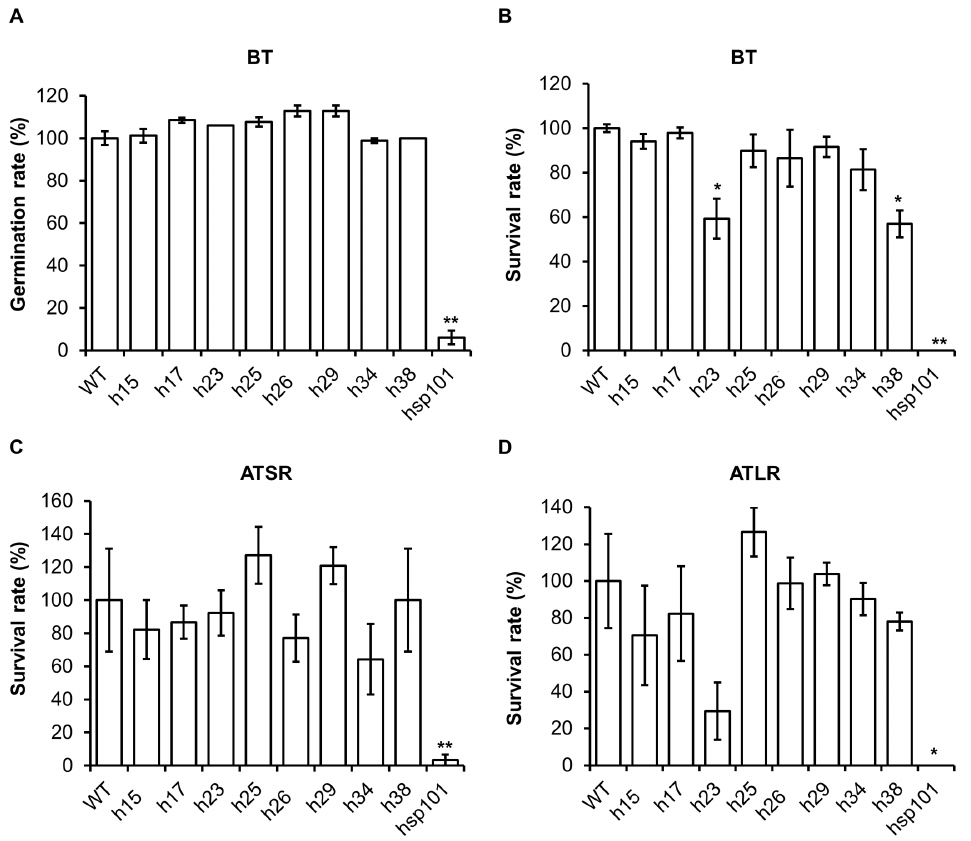
Figure 8. Heat stress treatment of mutant lines. (A) Germination rates for the BT assay. Seeds were treated at 45 u C for 5 h immediately after vernalization at 4 u C, and germination rates were measured after an additional 2 d. Survival rates for the BT assay at 45 u C for 30 min (B), ATSR assay at 45 u C for 150 min (C) and ATLR assay at 45 u C for 1 h (D). 7-d-old seedlings were used in analyses and survival rates of each sample was measured at 7 dafter heat stress. Data were collected from three replicates, each with 30 seeds or 20 seedlings. * and ** indicate significant differences compared with WT plants for P , 0.05 and P , 0.01, respectively, as determined by a t-test.